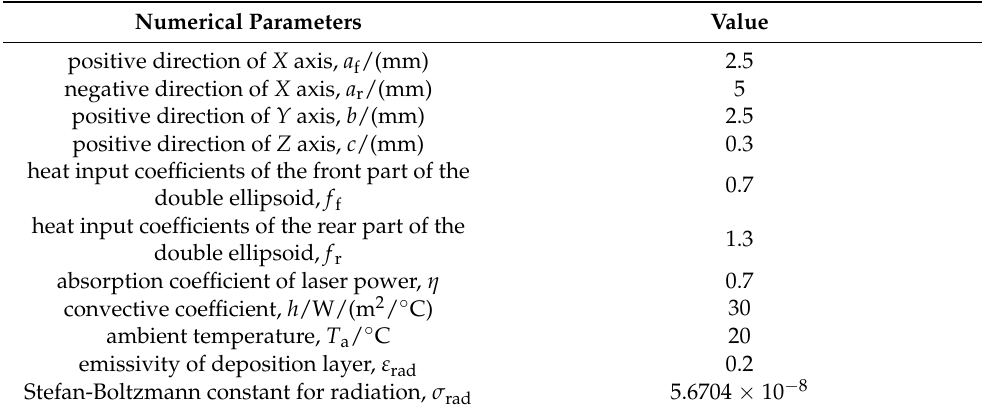
Table 3. Parameters used in the heat transfer